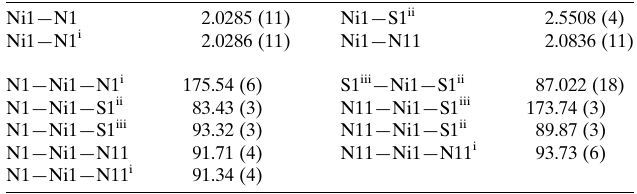
Table 1 Selected geometric parameters (A˚ , (cid:5) ).